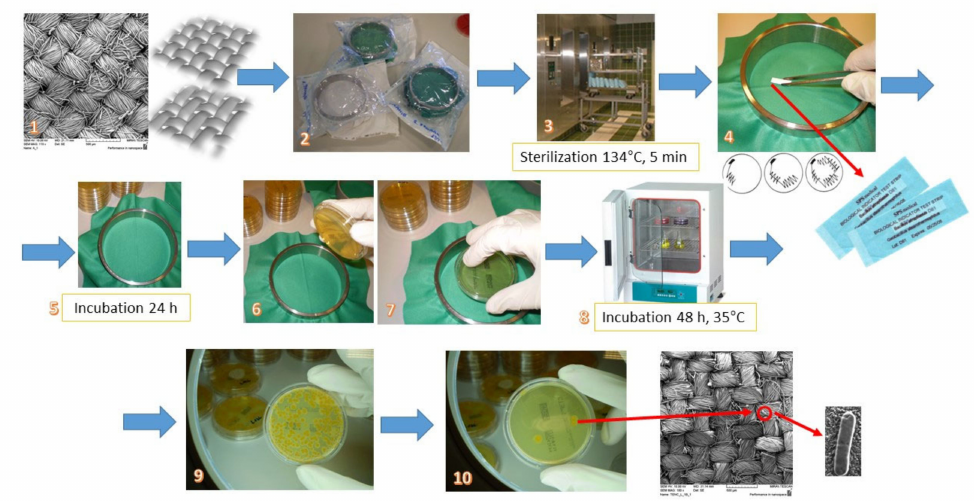
Figure 1. Schematic representation of microbial barrier permeability testing: